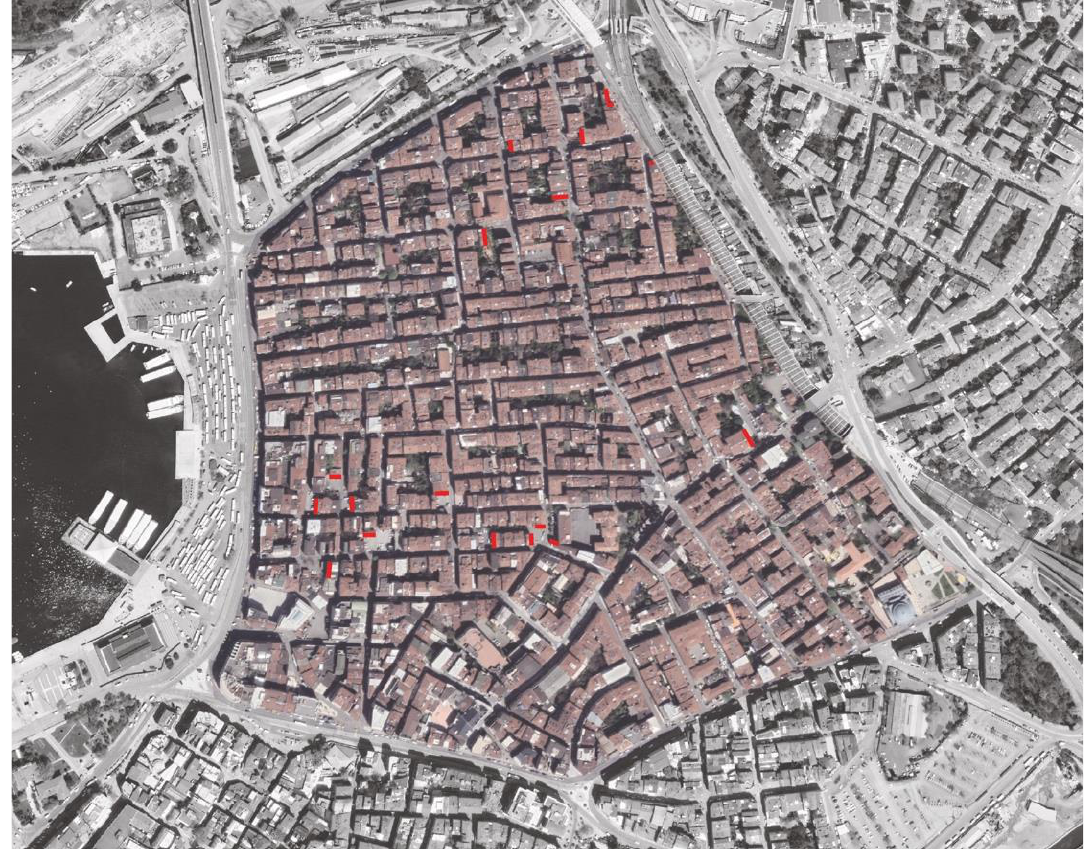
Figure 7 Distribution of the murals made after the Mural Festival in Yeldeğirme ni in